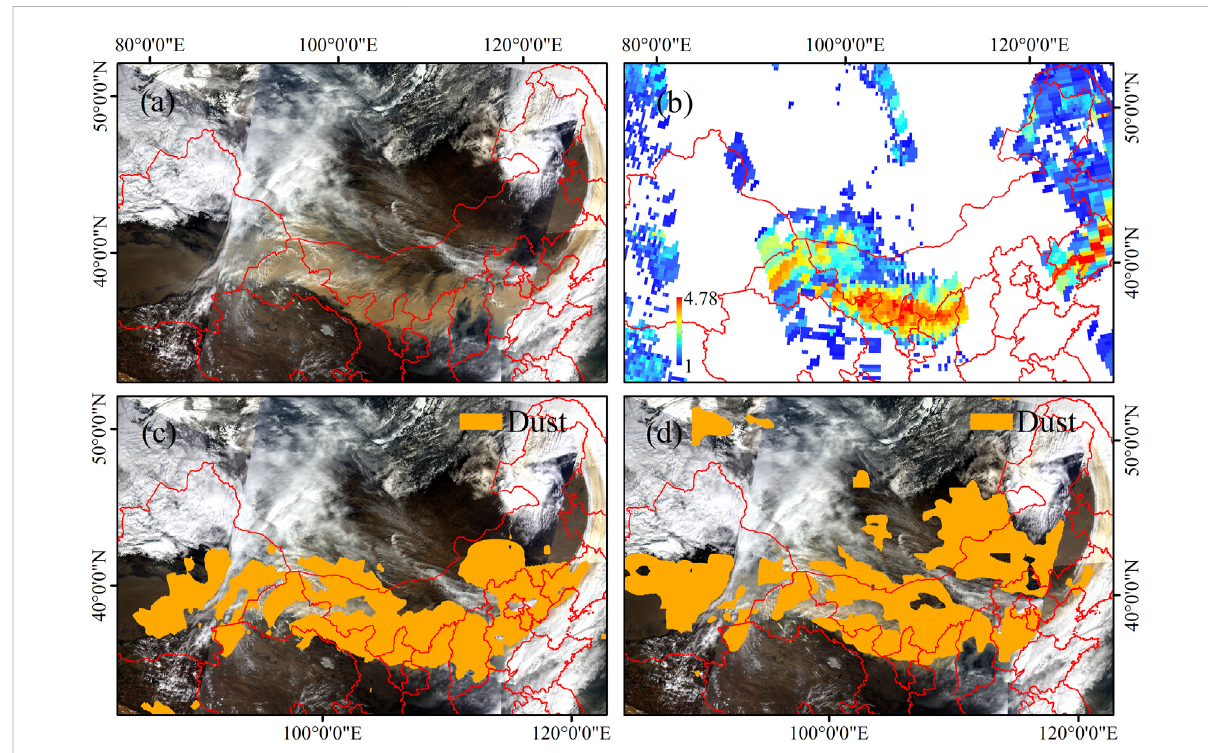
FIGURE 5 Spatial distributions of MODIS RGB image (bands:1-4-3) (A) , OMI AI product (B) , detection results of space sandstorms in MODIS images with LSR (C) , and detection results of space sandstorms in MODIS images without LSR (D) on 15 March